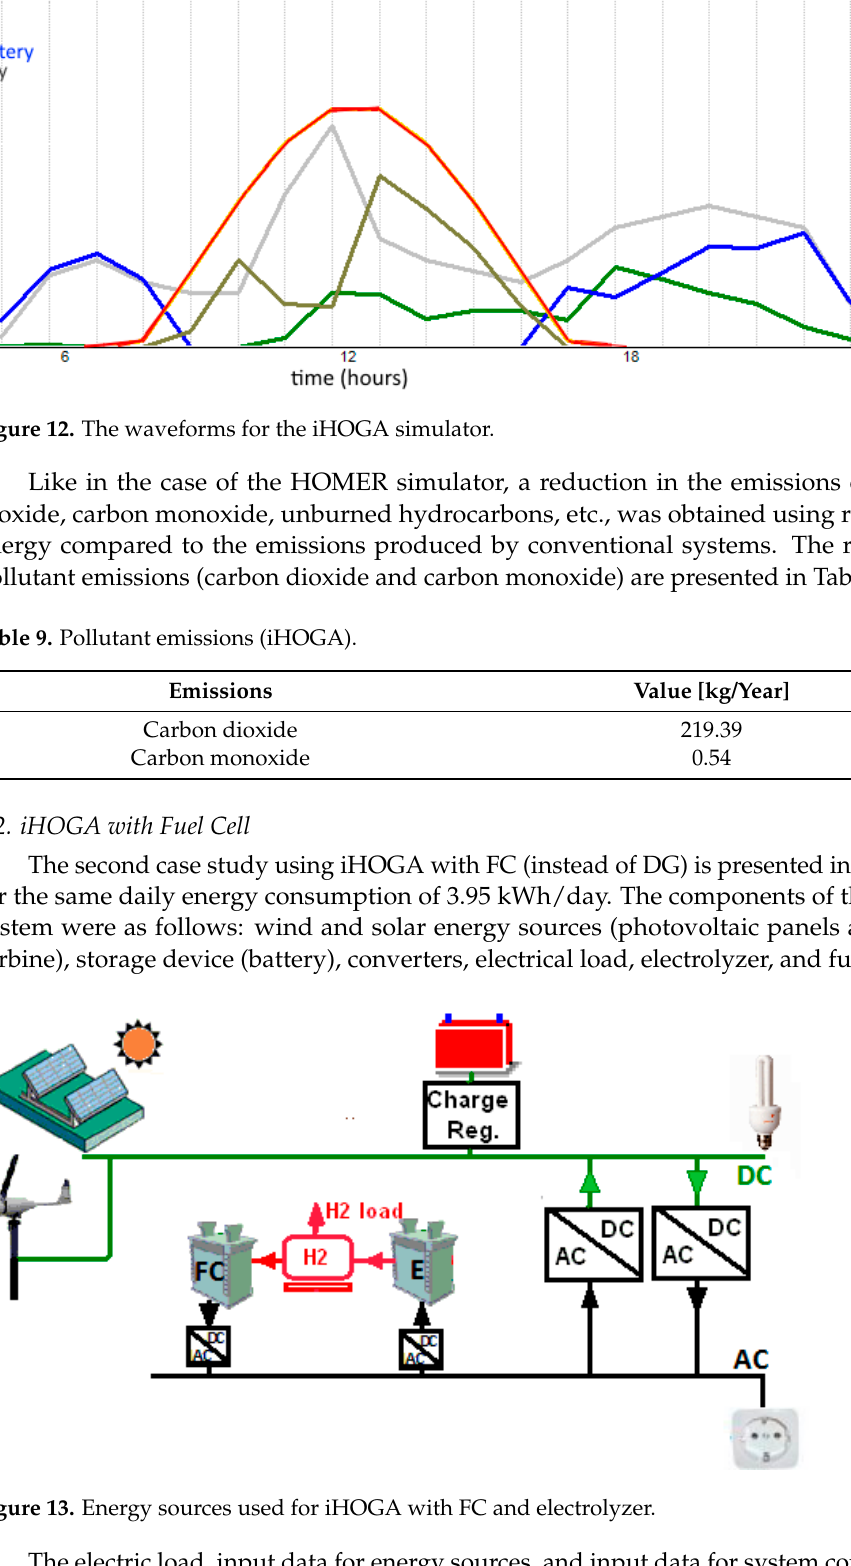
Table 10. The simulation results for the second case using iHOGA simulator.